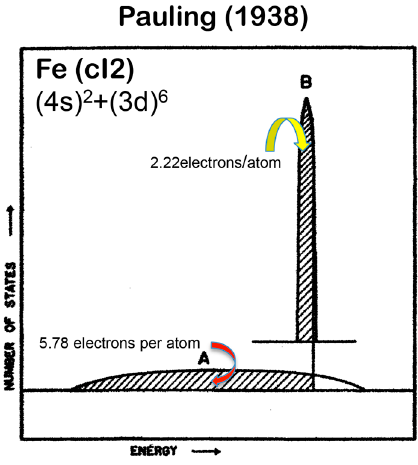
Figure 2 Pauling model of the valence band for 3d-elements like Fe (cI2) [10,11].